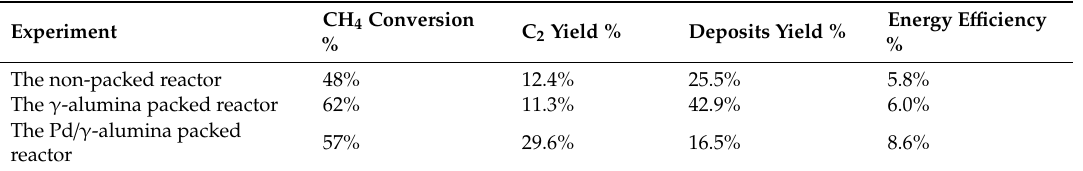
Table 2. The e ff ect of packing on the performance of the DBD plasma reactor for the present study, performed in specific energy input of 10–12 kJ /